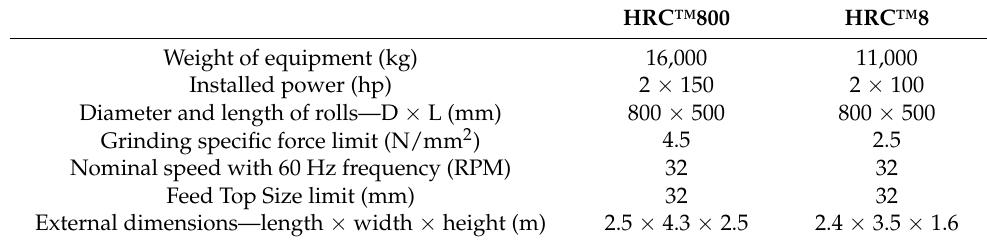
Table 1. HRC™ technical